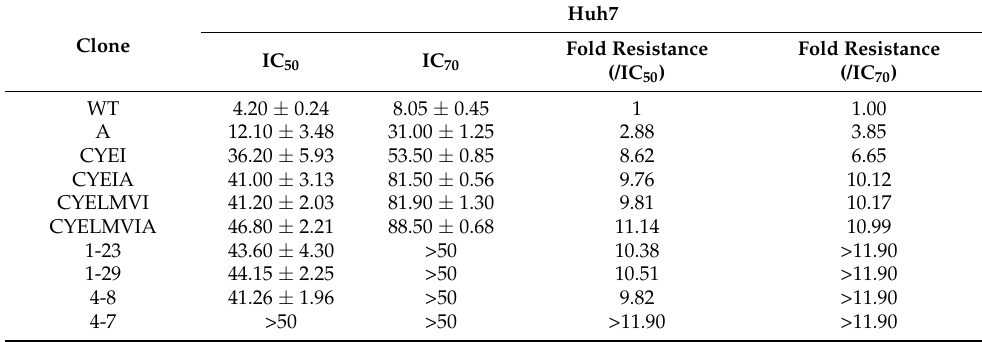
Table 3. Determination of IC 50 and IC 70 values of mutant clones against tenofovir in Huh7